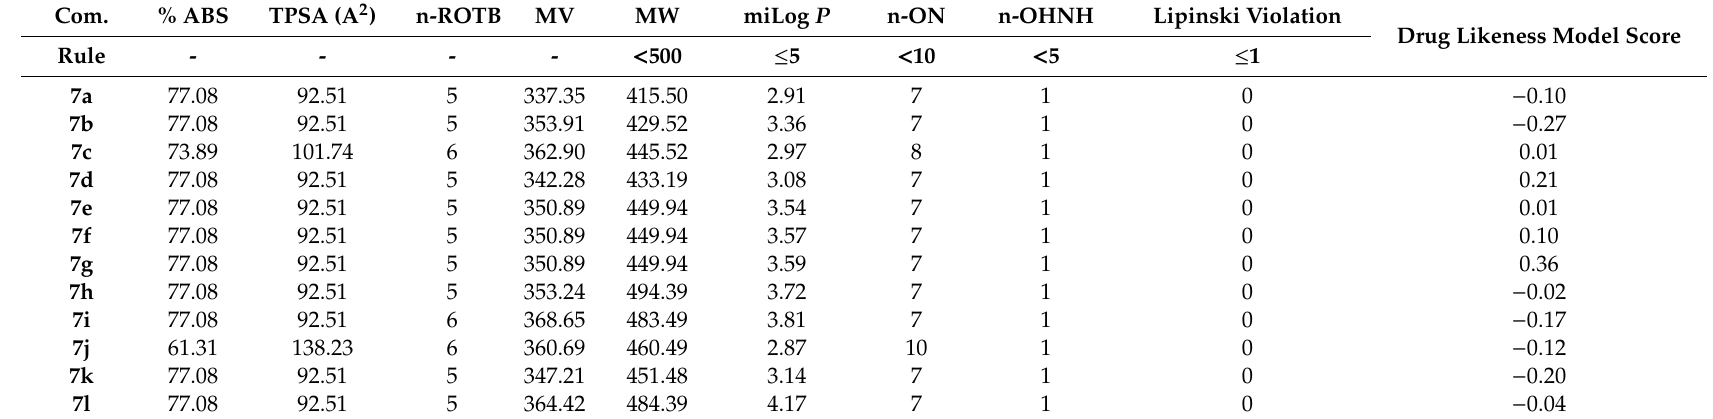
Table 5. Pharmacokinetic parameters important for good oral bioavailability and the drug likeness model scores.